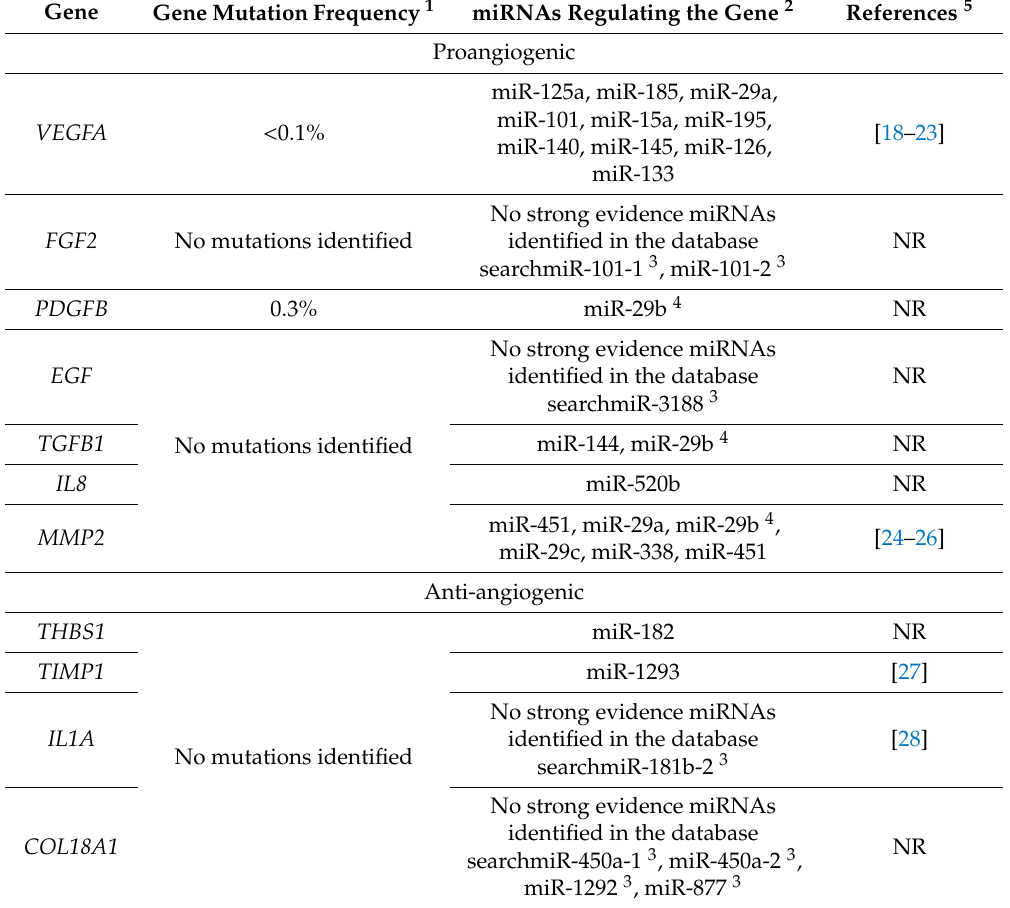
Table 1. The main proangiogenic and anti-angiogenic factors, along with a selection of miRNAs that target their